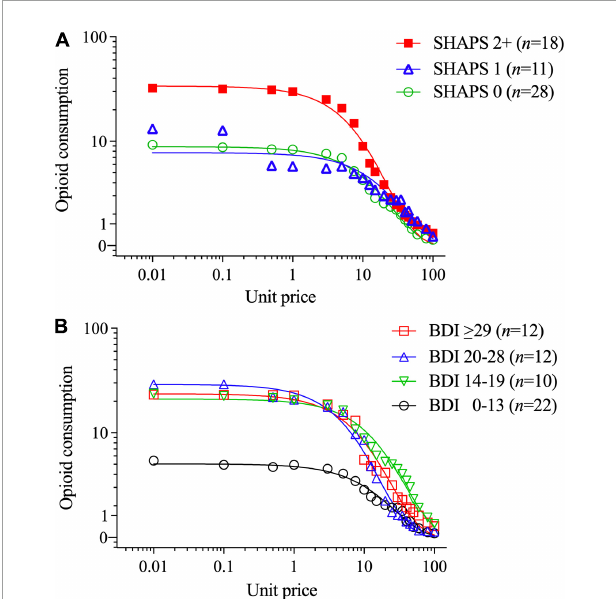
FIGURE2 Opioid demand stratified by (A) Snaith-Hamilton Pleasure Scale (SHAPS) anhedonia total scores (0 vs. 1 vs. 2+) and (B) Beck Depression Inventory-II (BDI-II) scores (using clinical cutoff values). The primary SPSS analysis found significant SHAPS anhedonia group differences in opioid demand (see text, Section “3.1. Aim 1: Differences between BZD misusers and never-misusers”), and parameters computed in GraphPad Prism from group-average curves in Figure 1A confirm that the subgroup with SHAPS scores ≥ 2 compared to scores of 1 or 0 had higher opioid demand intensity ( Q 0 = 33.7 vs. 7.64 vs. 8.75, respectively), and essential value ( EV = 7.75 vs. 2.98 vs. 2.36, respectively), F (1,18) = 84.2. The primary SPSS analysis did not find a significant BDI-II group difference in opioid demand intensity or essential value; however, parameters computed in GraphPad Prism from group-average curves in Figure 1B found that BDI-II scores indicating mild or greater depression severity ( ≥ 14) were associated with higher opioid demand intensity ( Q 0 = 4.9, 21.0, 29.0 and 23.5 for groups with scores of 0–13, 14–19, 20–28, and ≥ 29, respectively) and essential value ( EV = 1.32, 8.24, 4.91, and 5.75, respectively), F (1,18) =